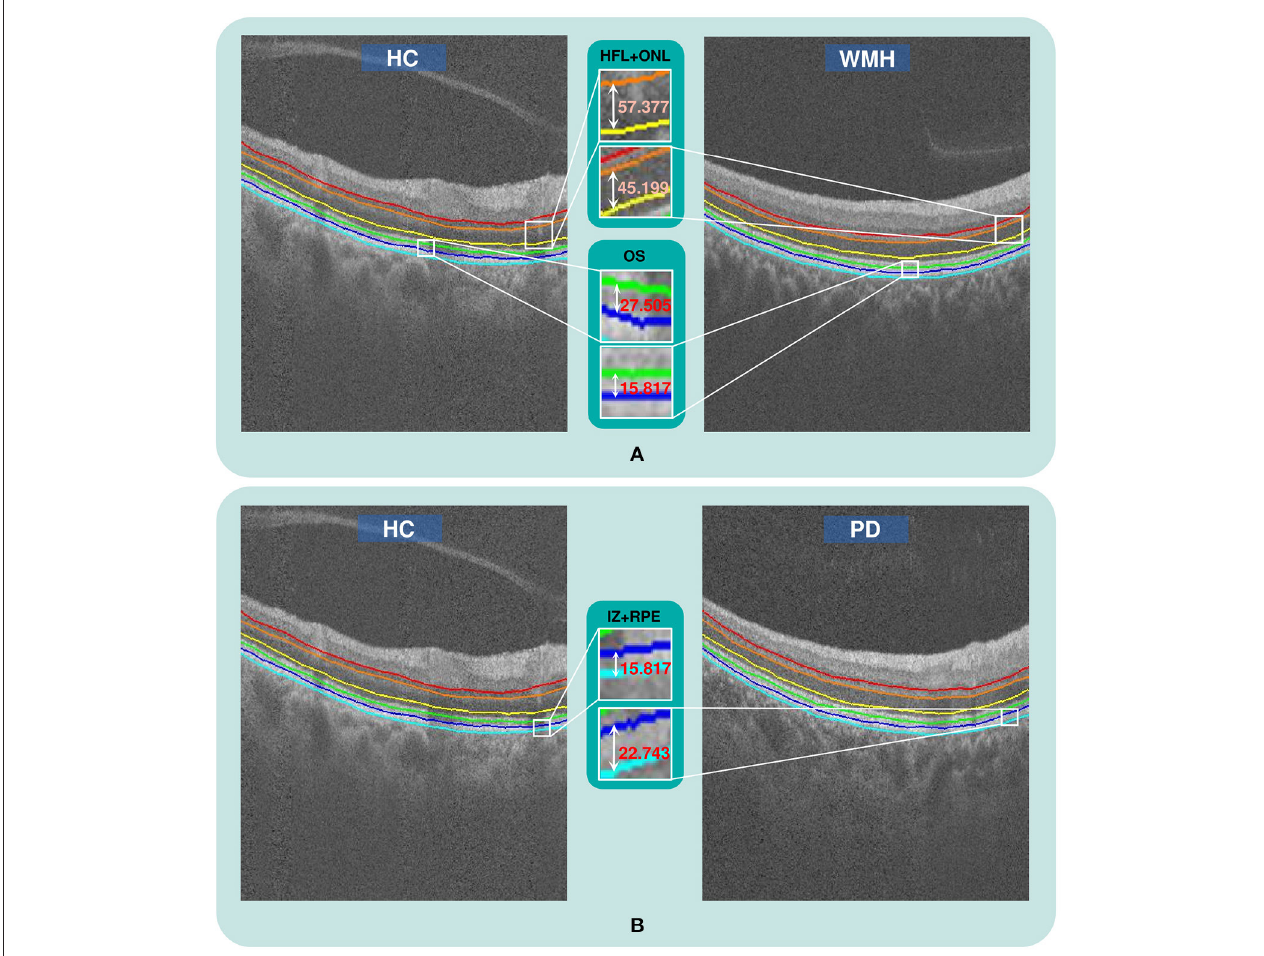
FIGURE 2 | The qualitative comparison of outer retinal layer thickness. (A) The thickness of the HFL+ONL and OS layers in a WMH case is obviously reduced compared with a healthy subject from the HC group, (B) The thickness of the IZ+RPE layer in a PD case is obviously greater than in a HC